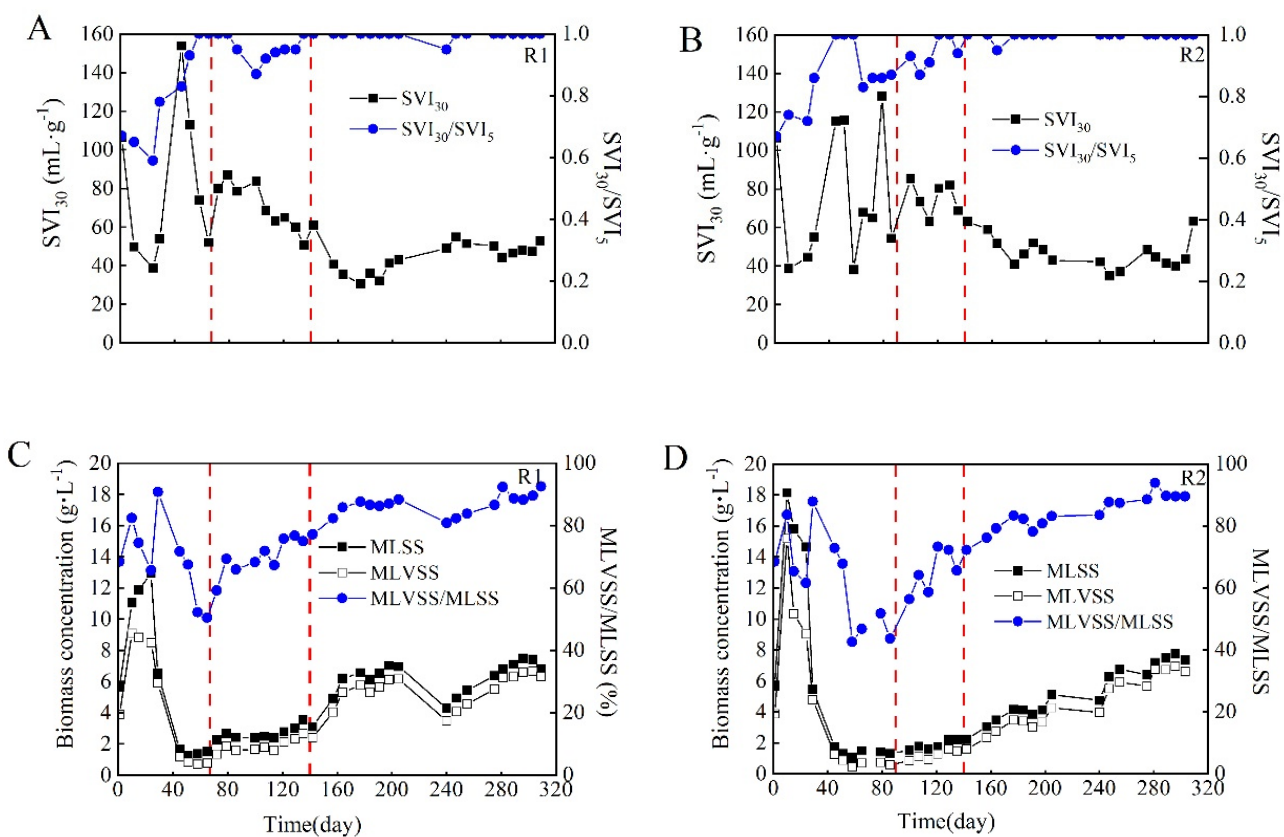
Figure 4. Profiles of SVI and MLSS during the operation period. ( A , C ), in R1; ( B , D ), in